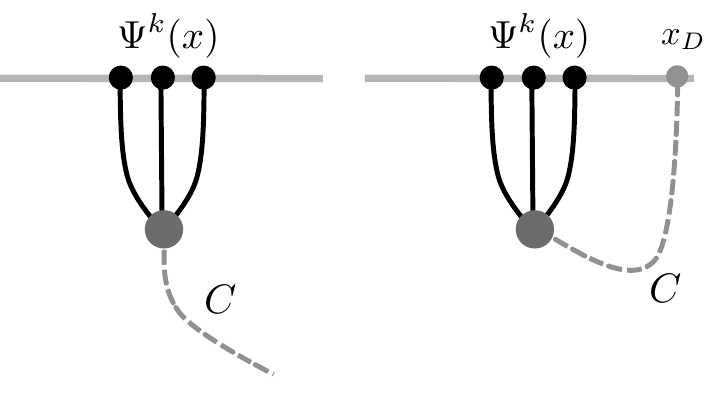
Figure 6: When k bulk Wilson lines can end on a monopole event in B in the bulk, a Dirac string C emerges from the monopole: we will distinguish the case where the string stays in the bulk (left) and the case where the string hits the boundary at x D